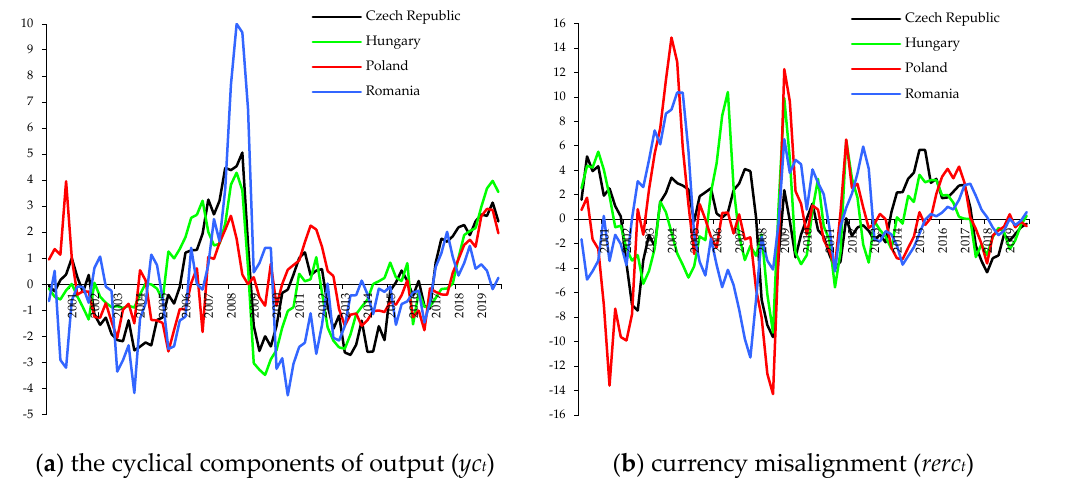
Figure 1. Business cycle and currency misalignment, 2000–2019 (in %). Source: own calculations based on data from IMF International Financial Statistics (www.data.imf.org, accessed on 8 February 2021).